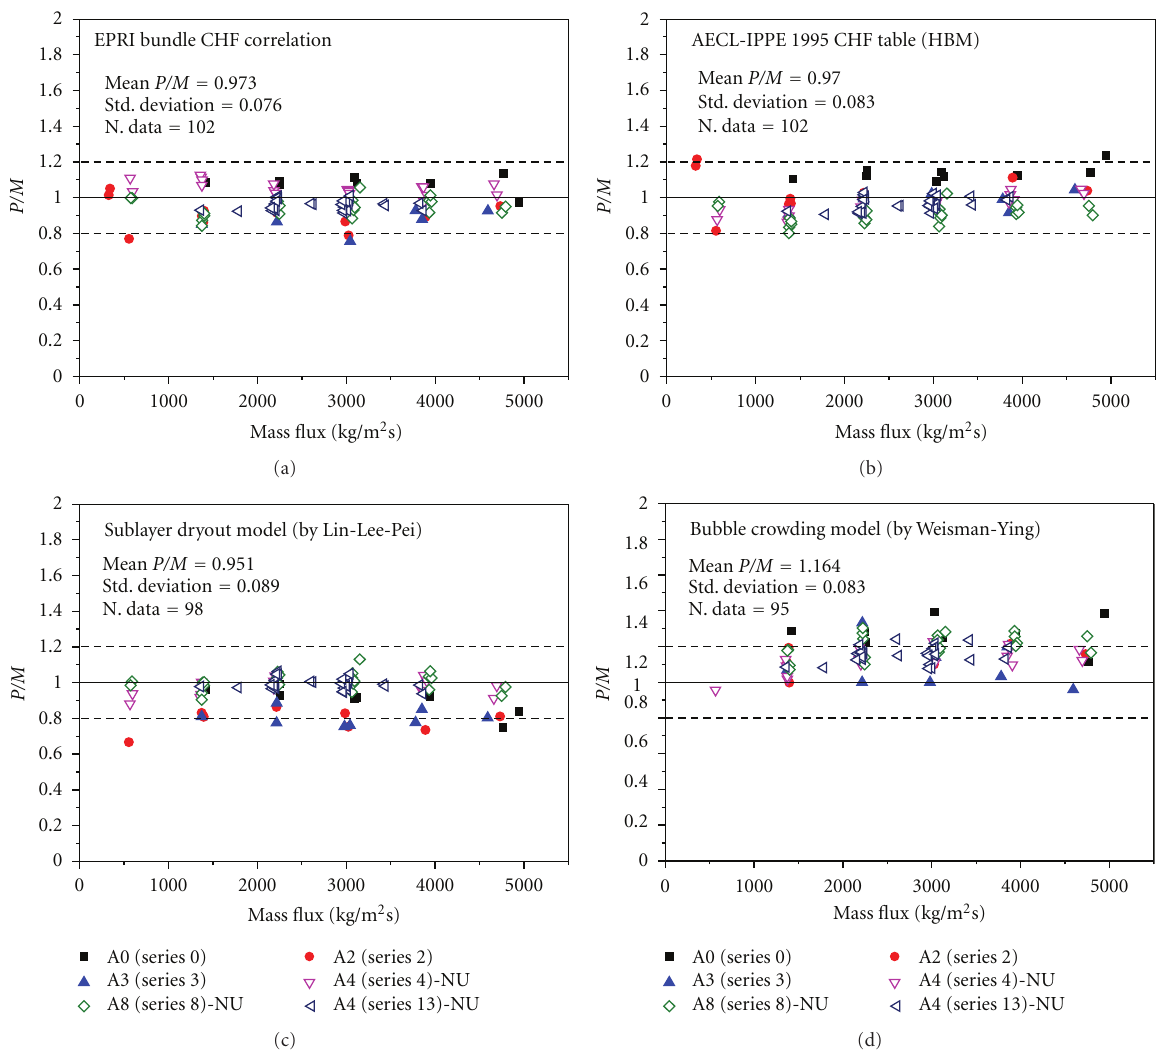
Figure 9: Accuracy of various CHF prediction models with MATRA for steady-state DNB benchmark.